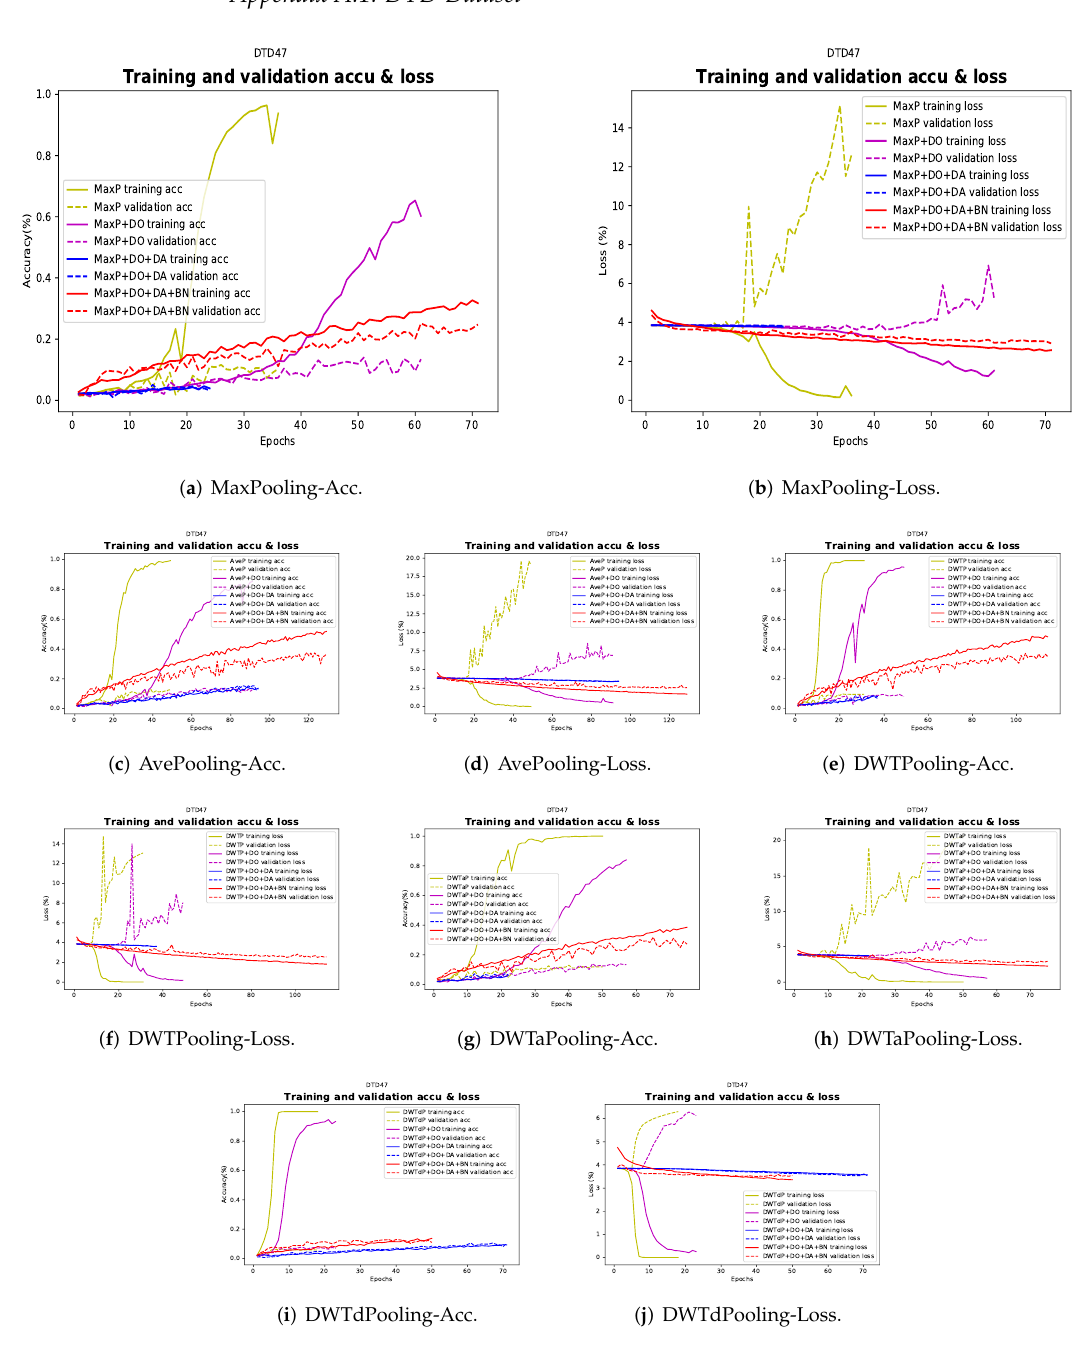
Figure A1. Learning behavior for baseline architecture + pooling, increasing DropOut, Data Aug- mentation, and Batch Normalization—DTD